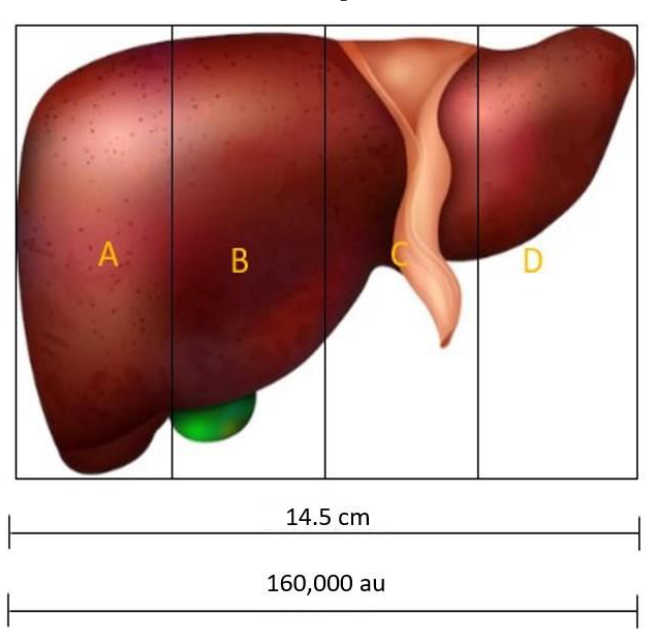
Figure 5. Liver bisected in 4 regions to inject the NSs in each one. Table 7. The best individual found in case 2 for the dataset [37] and different